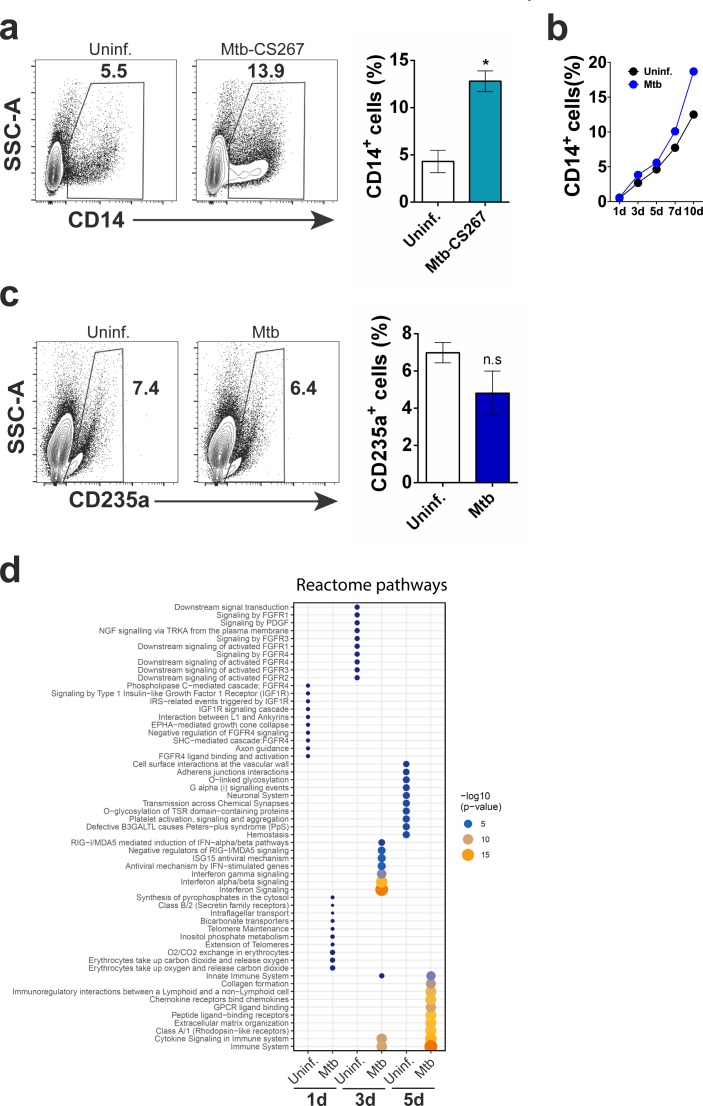
Monocyte differentiation and reactome pathways associated to Mtb-exposed CD34+ cells in vitro.(a) Frequencies of CD14+ cells during 10 day exposure to a clinical isolate of Mtb. *p≤0.05 between Mtb-CS267 vs uninfected groups. (b) Purified CD34+ cells were exposed to Mtb H37Rv for 1, 3, 5, 7 and 10 days and flow cytometry was employed to determine the CD14+ monocyte frequency. (c) The erythroid cell marker CD235a was measured by flow cytometry in Mtb-exposed and uninfected purified CD34+ cells at 10 dpi. Results shown are representative from two experiments. (d) Enrichment of Reactome pathways based on gene signatures derived from each experimental condition. Gene signatures were composed by genes with log2 fold change >0.75 when comparing one experimental condition versus all others. The size and color of the circles are proportional to -log10 of the adjusted p-value.10.7554/eLife.47013.013Figure 3—figure supplement 1—source data 1.Raw data from Figure 3—figure supplement 1.